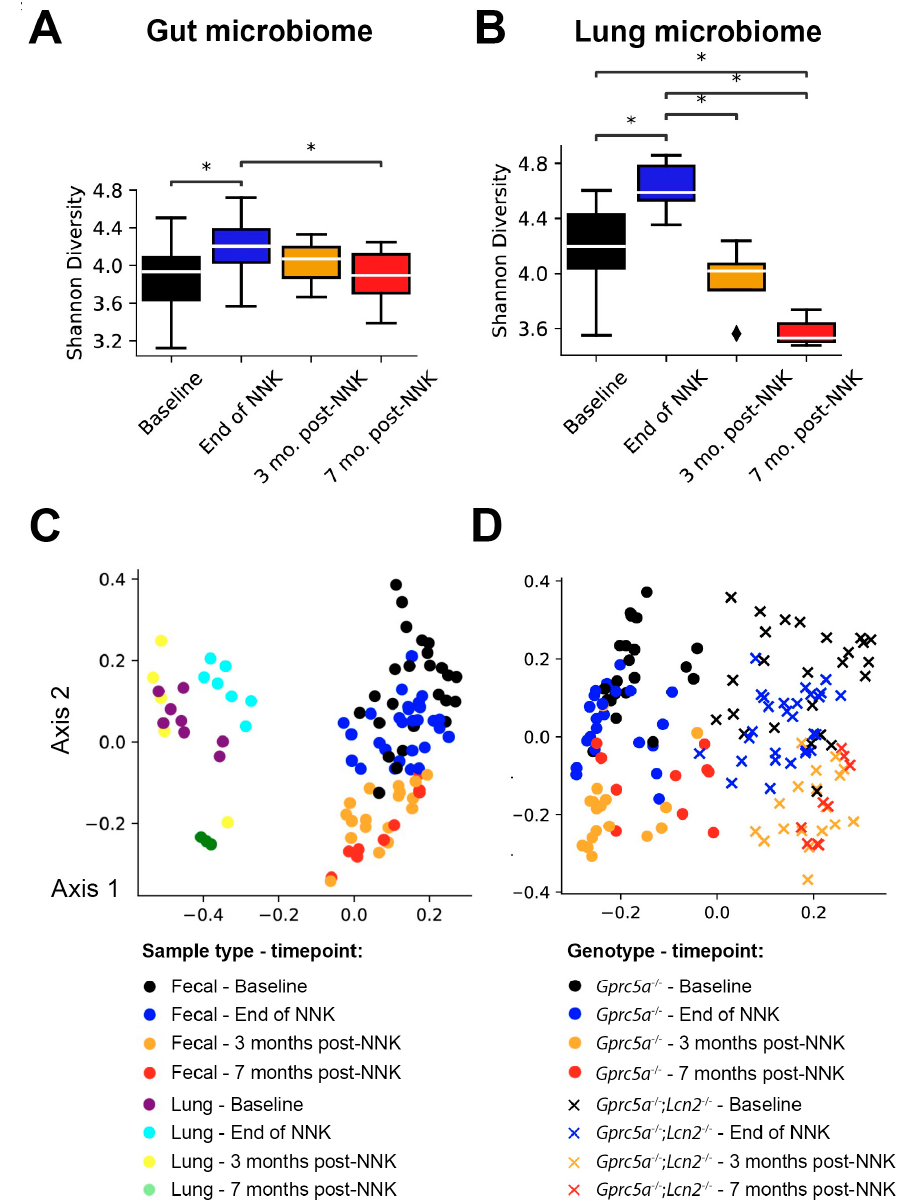
Figure 4. Gut and lung microbiome changes during the phenotypic evolution of tobacco carcinogen- associated LUAD in Gprc5a − / − ; Lcn2 − / − animals. ( A ) Gut microbiome α -diversity evaluated using the Shannon index of Gprc5a − / − ; Lcn2 − / − fecal samples collected at baseline, end of NNK, three-, and seven months post-NNK. ( B ) Lung microbiome α -diversity evaluated using the Shannon index of Gprc5a − / − ; Lcn2 − / − lung tissues collected at baseline, end of NNK, three-, and seven months post-NNK. Shannon indices were calculated using the species-level OTUs. Differences in alpha diversity among the various time points were investigated using an ANOVA and Tukey’s post hoc test where necessary. *, p < 0.05; (cid:7) , Outlier. ( C ) Bray–Curtis and OTU-based clustering of fecal and lung samples showing segregation based on sample type (axis 1) and timepoint (baseline, end of NNK, three- and seven months post-NNK; axis 2). ( D ) Bray–Curtis and OTU-based clustering of fecal samples showing segregation based on genotype (axis 1) and timepoint (baseline, end of NNK, three- and seven months post-NNK; axis 2). The Bray–Curtis dissimilarity matrix was used as input to the principal coordinate analysis to visualize the data. Clustering observed in the data was tested for statistical significance using an AMOVA with 10,000 iterations. NNK: nicotine-specific nitrosamine